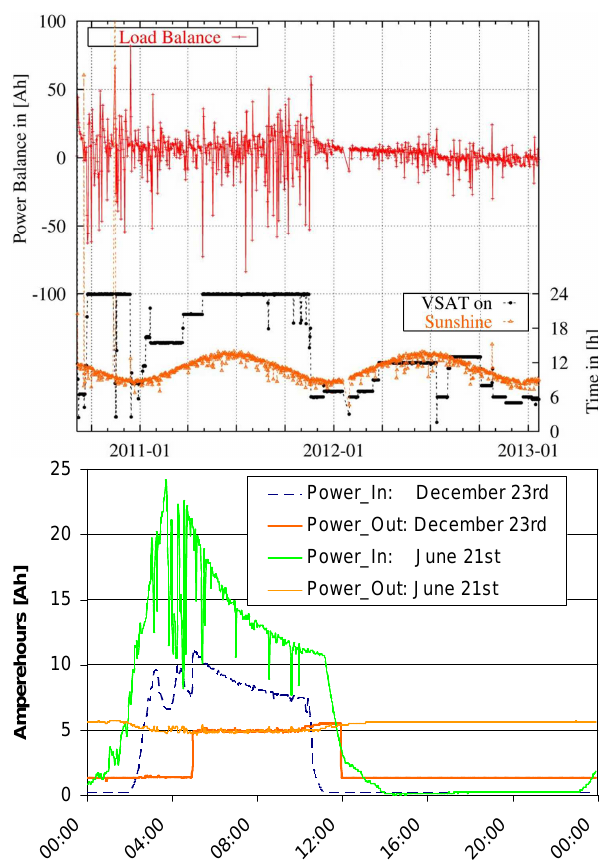
Fig. 8. (a) Power balance for Taragay (red line, left axis) is close to zero. The variability during winter time is related to periods with cloudy skies. The black line indicates VSAT on-times (right axis). The orange line (right axis) shows daily sunshine hours with the distinct annual cycle. (b) Power Charge (green, blue) and Load (or- ange) at Taragay station for 21 June and 23 December of 2011. The solar input and output is 145Ah/127Ah and 70Ah/58Ah, re- spectively. For summer times, VSAT connection is maintained for 24h, while in inter times, VSAT is available depending on the power level.